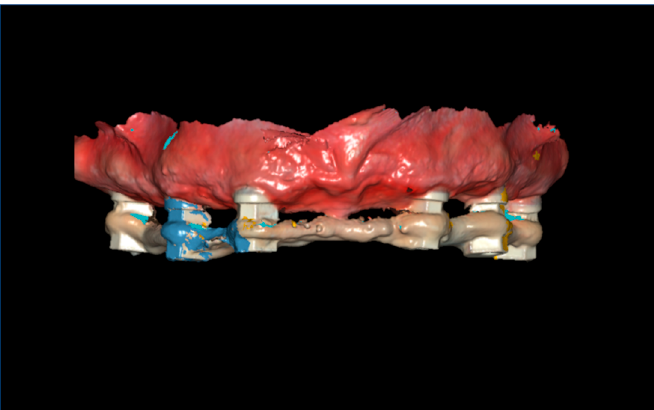
Figure 1. Full-arch digital scan with splinted scan bodies.